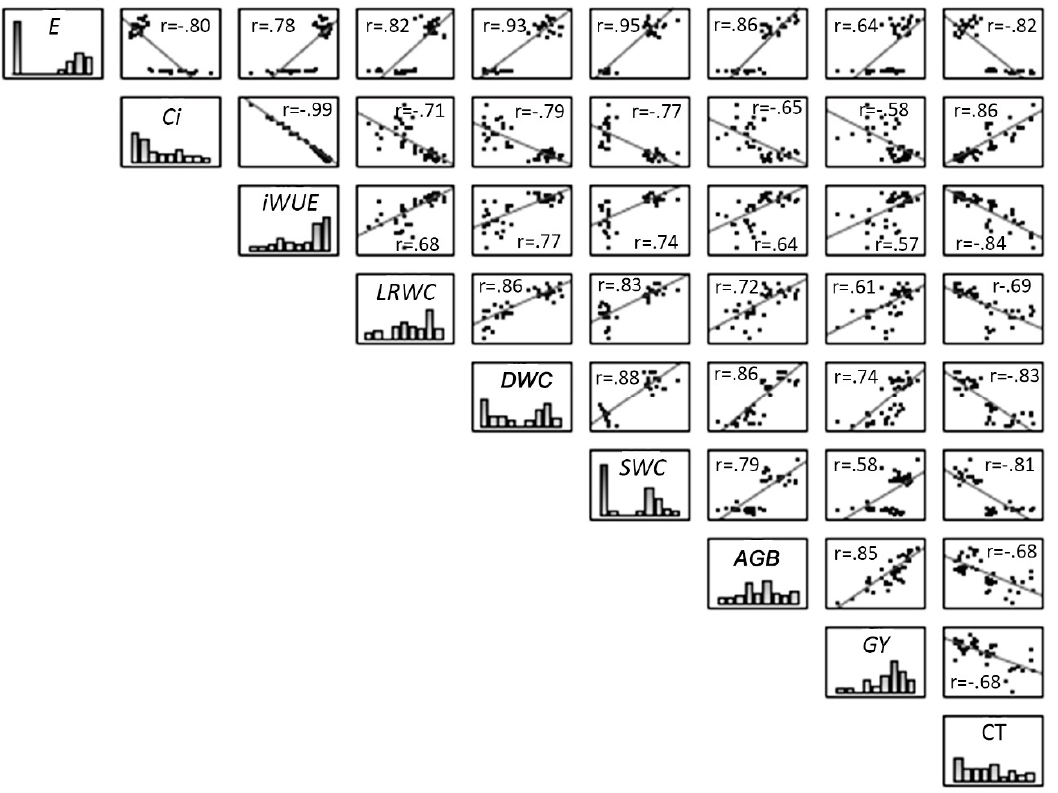
Figure 7. Relationship between variables measured in the experiment for control and drought stressed maize plants in the 12th day of stress, which are represented using regression lines in the plots. The numerical figures displayed provide the correlation coefficients. The p values was <0.01 for all the plotted variables. E – Transpiration rate, Ci – Intercellular CO 2 concentration, iWUE – Intrinsic water use efficiency; LRWC – Leaf relative water content; DWC – Daily water consumption (water lost by evapotranspiration); SWC – Soil water content; AGB – Aboveground biomass; GY – Grain yield; CT – Canopy temperature.